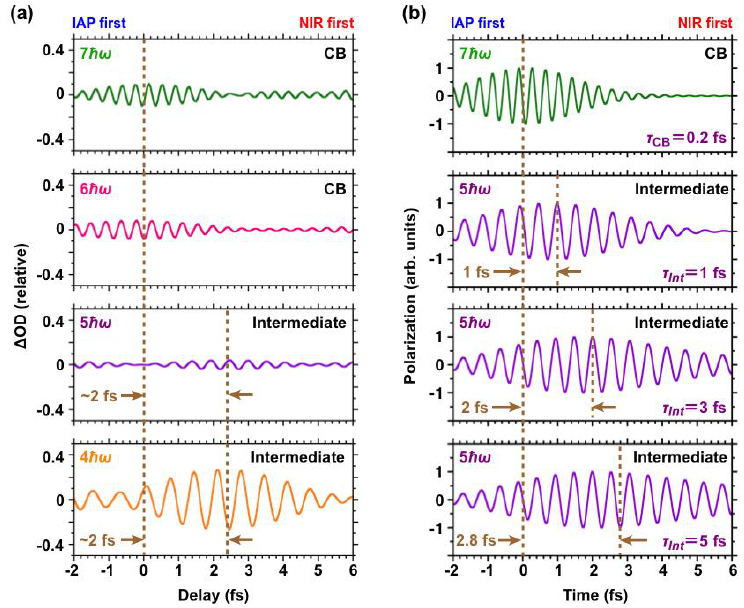
Fig. 3. Time-dependent dipole oscillation and polarization. (a) Measured dipole oscillation in Fig. 2(a) after windowed Fourier transform. The window energies of Fourier filtering are 6.2 (4 ħω ), 7.7 (5 ħω ), 9.2 (6 ħω ), and 10.8 eV (7 ħω ). The applied window energy width is ±0.35 eV, taking into account the NIR bandwidth. The 4ħω and 5ħω correspond to the intermediate state. The 6 ħω and 7 ħω correspond to the CB state. The electric dipole oscillations with periodicities of 667 (4 ħω ), 537 (5 ħω ), 450 (6 ħω ), and 383 as (7 ħω ) correspond to frequencies of 1.5, 1.9, 2.2, and 2.6 PHz, respectively. (b) Calculated time-dependent polarization. Upper trace (purple solid line) shows the Fourier filtered polarization in the CB state (7 ħω ) with τ CB =0.2 fs. (d) CB resonances. Bottom three traces show Fourier filtered polarizations in the intermediate state (5 ħω ) with τ Int =1, τ Int =3, and τ Int =5 fs, respectively. The brown dotted lines and arrows show the time delay between the CB and intermediate